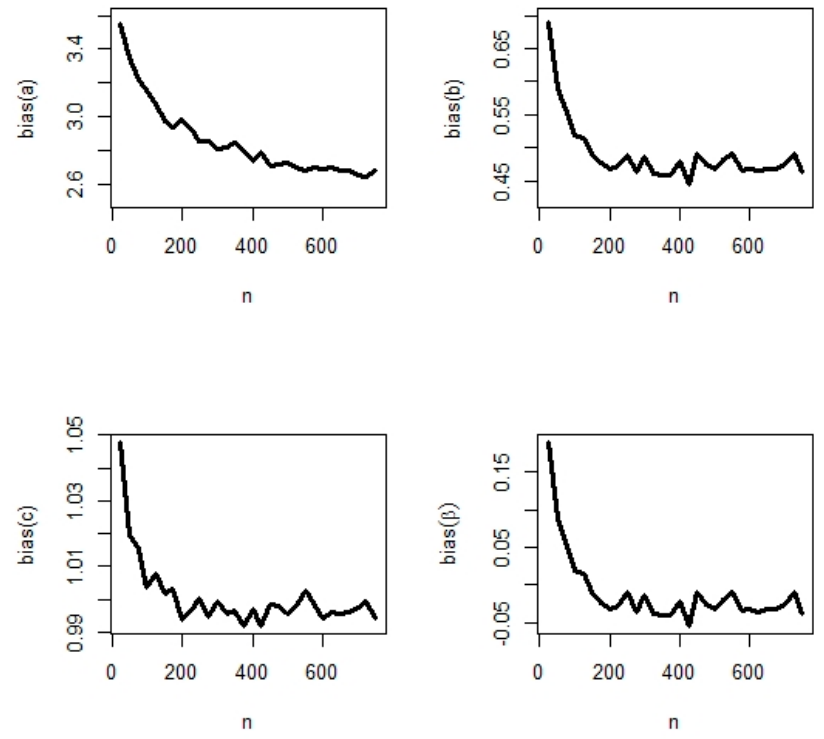
Figure 3. The biases of the estimates of parameters of the GOLE-W distribution.